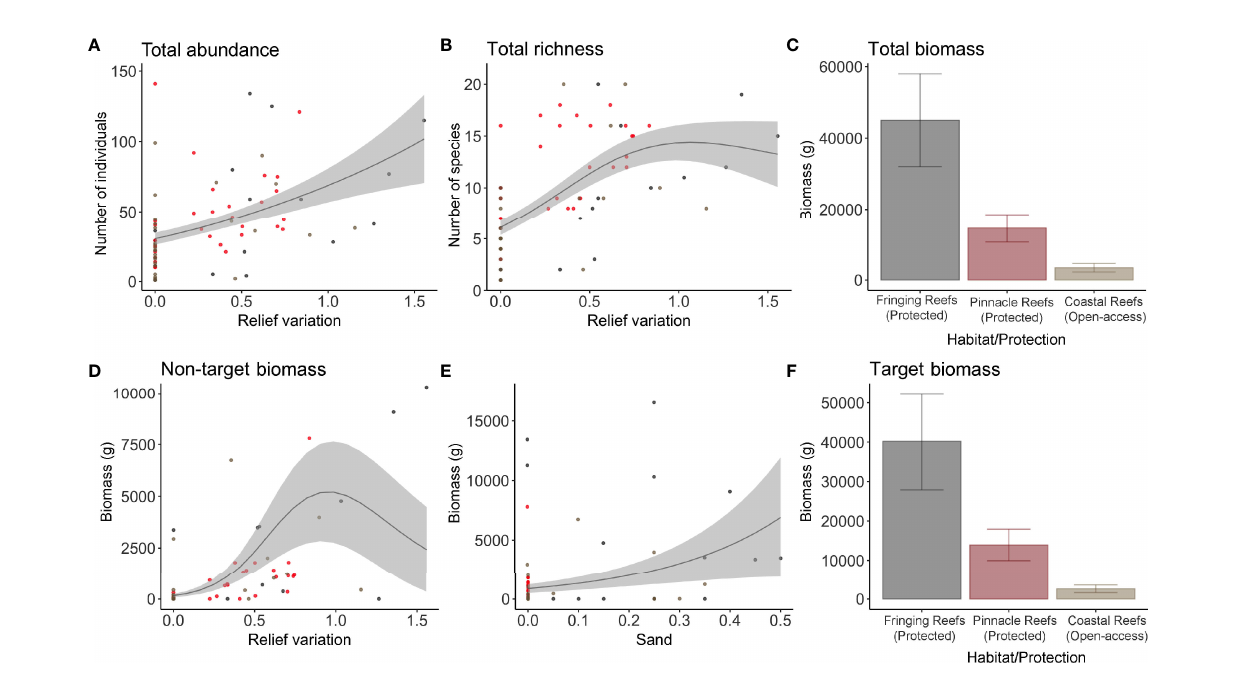
FIGURE 3 | Most parsimonious models for the overall characteristics of the fi sh assemblage, total abundance (A) , total richness (B) , and total biomass (grams) (C) . Plots of the most parsimonious models selected for biomass (grams) of fi sheries non-target (D, E) and (F) target fi sh species. Each dot represents a sample, in which the gray dots represent the Fringing Reefs, red dots the Pinnacles Reefs, and beige the Coastal